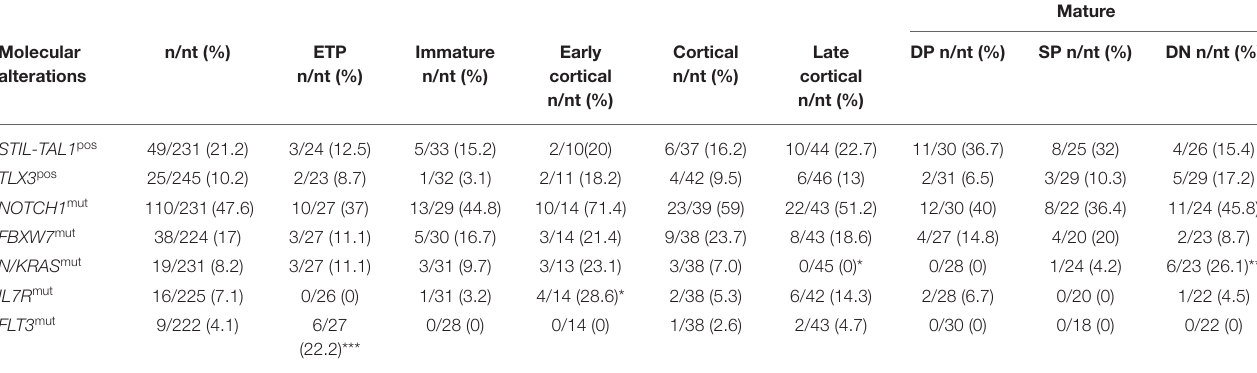
TABLE 2 | Molecular alterations according to pediatric T-cell Acute Lymphoblastic Leukemia subtypes, Brazil